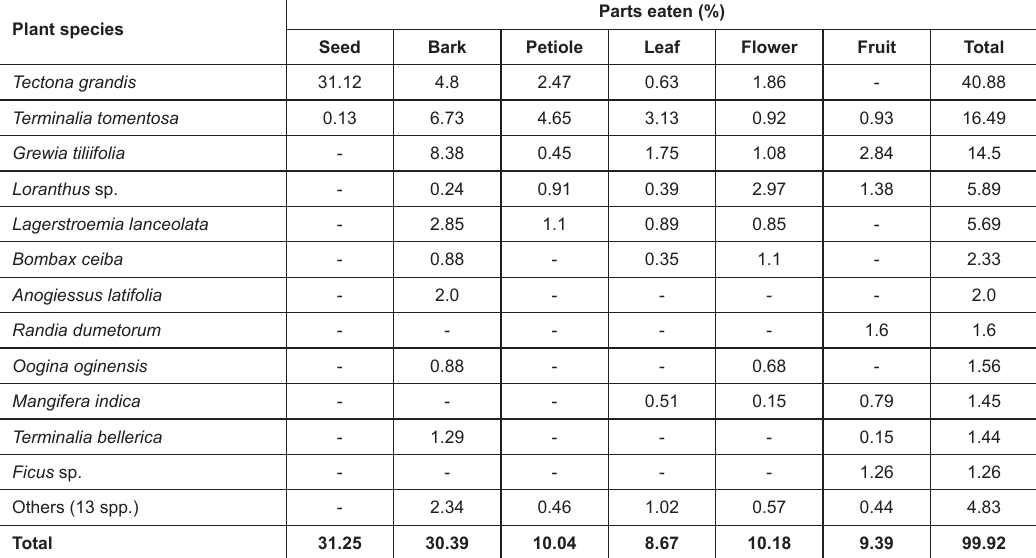
Table 2. Percent contribution of various plant species and their parts to the diet of Indian Giant Squirrel in Mudumalai Wildlife Sanctuary Plant